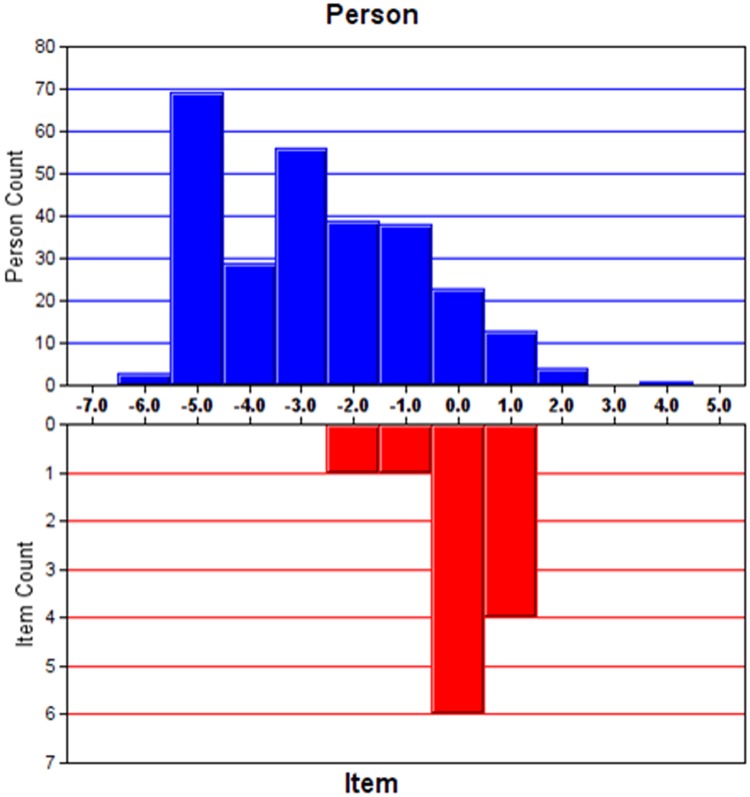
Person-item location distribution for HADS- Total.